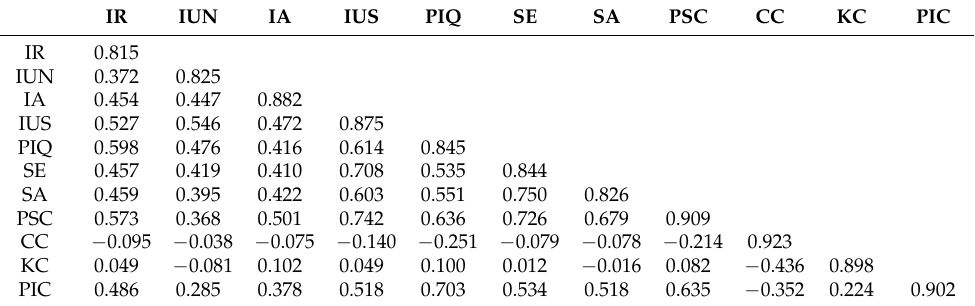
Table 5. Latent variable correlations.